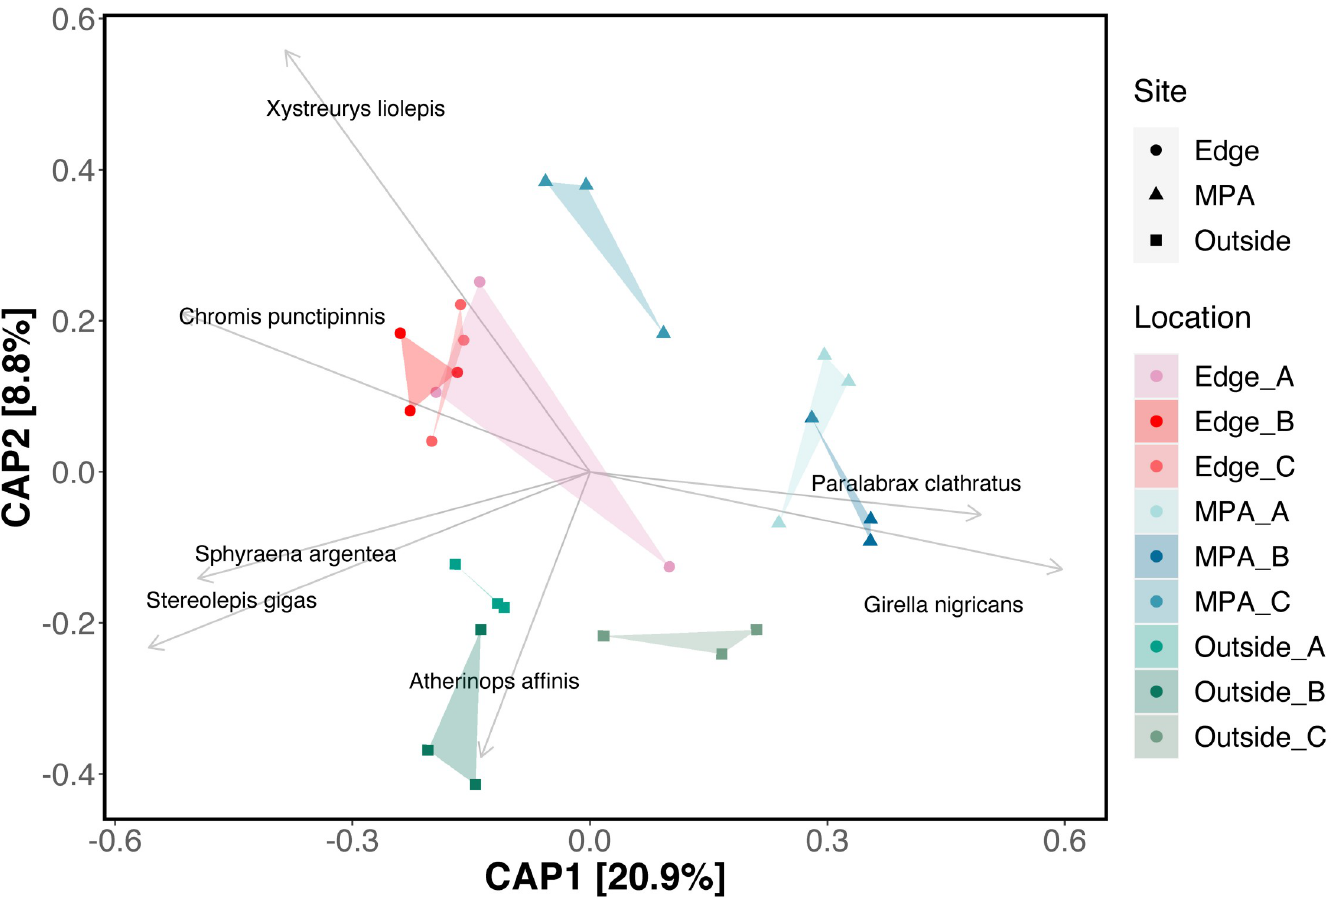
Fig 5. Constrained analysis of principle components (CAP) ordination. Bray-Curtis dissimilarities were calculated between all samples using only species with occupancy rates over 84%. Samples from sites and locations within sites were used as independent variables. Site and locations within sites are significantly more similar to each other (CAP, p < 0.001). Sites (shapes) and Locations (colors) are plotted against CAP1 and CAP2 axes. Arrows correspond to direction and strength (length) of each species. Only the top seven species with CAP distances greater than 0.40 were